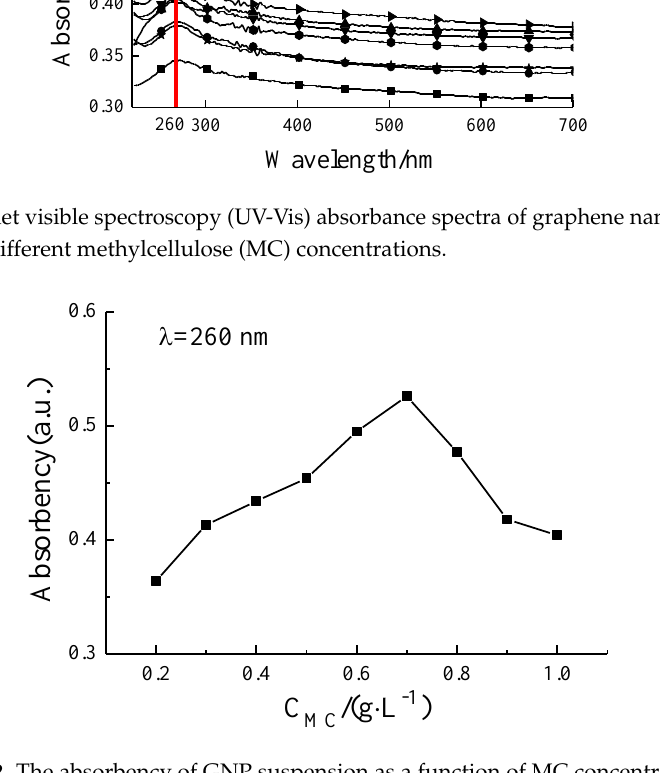
Figure 2. The absorbency of GNP suspension as a function of MC concentration.